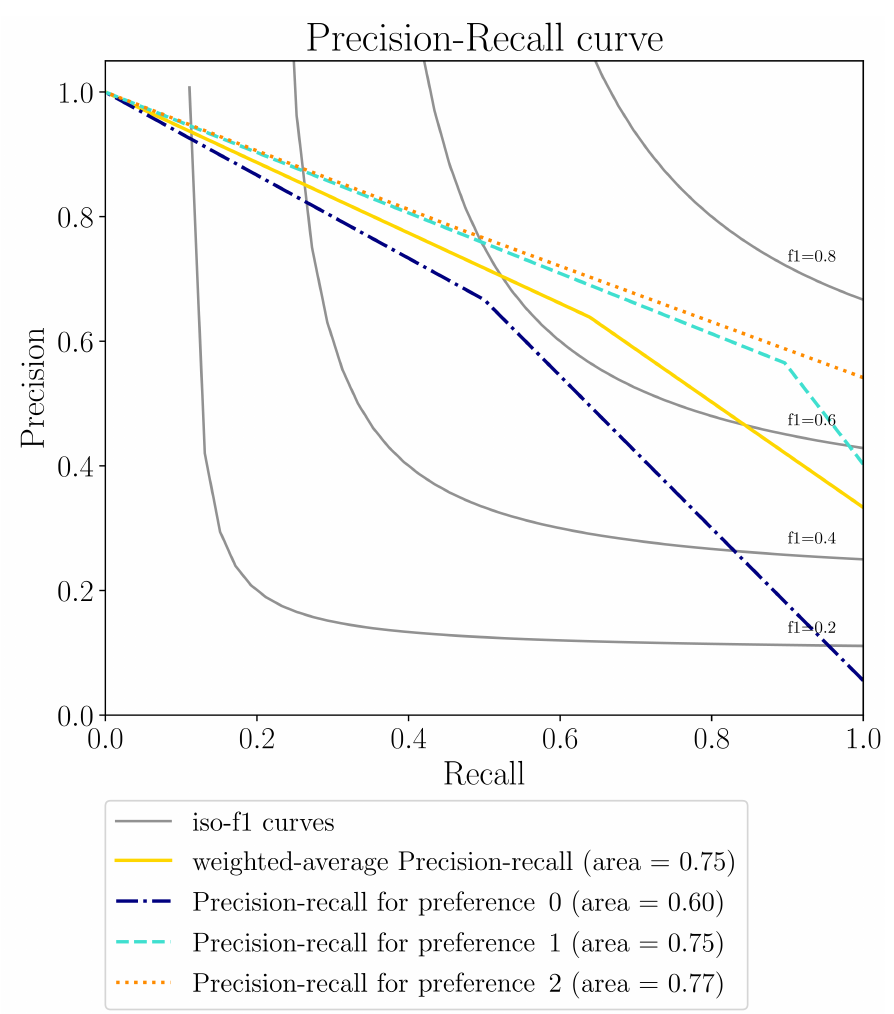
Figure 9. Precision–Recall curve for the VU-enabled profiling w.r.t. manual Figure 9. Precision-Recall curve for the VU-enabled profiling w.r.t. manual profiling.